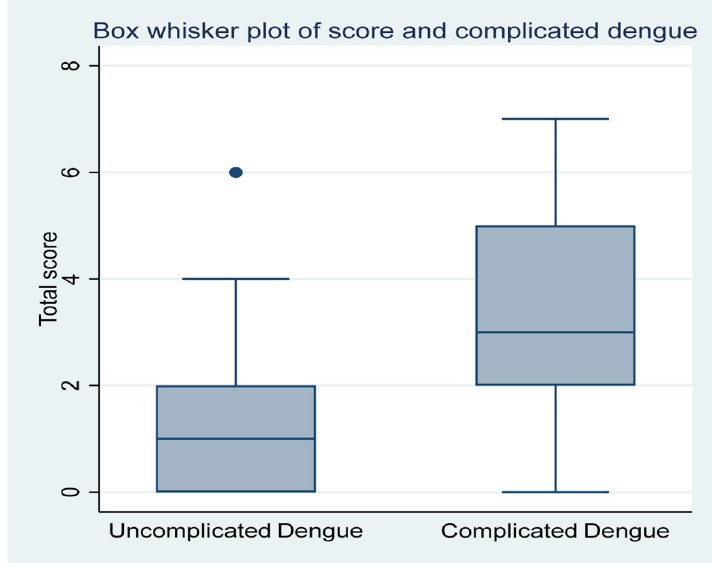
Figure 2. Distribution of Dengue Severity Scores using the predictive model in the sample